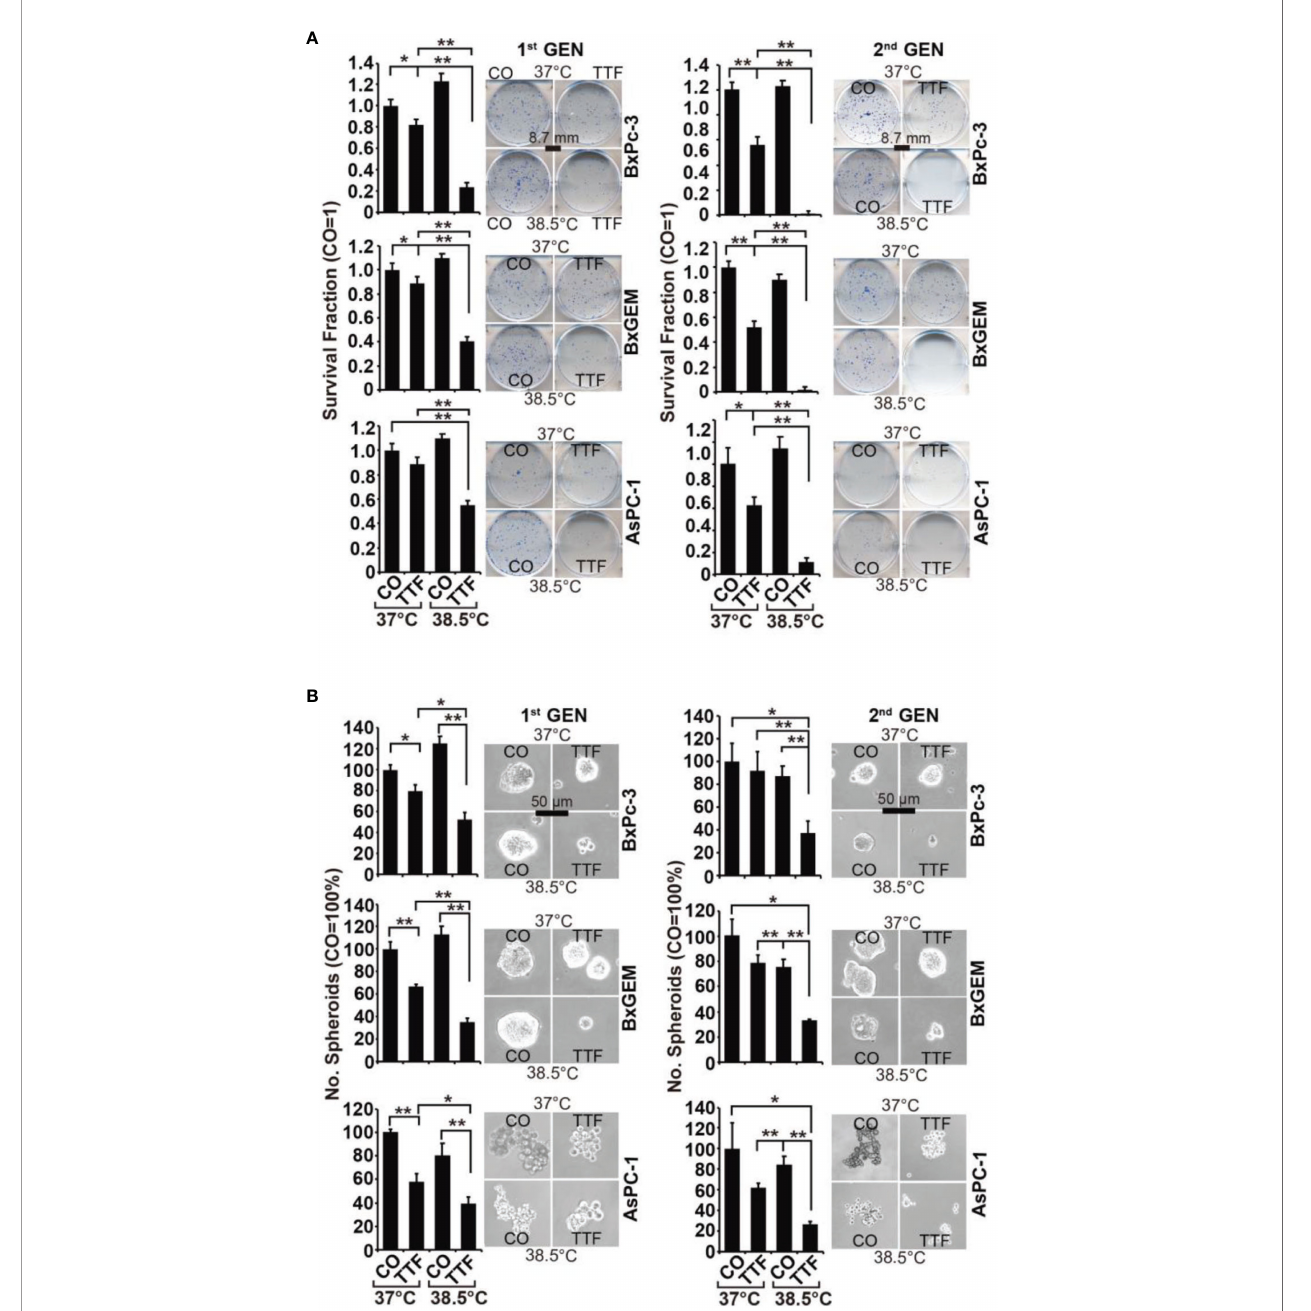
FIGURE 2 | TTField-mediated inhibition of cancer stem cell features is enhanced by hyperthermia. (A) The cells were treated as described in Figures 1A, B , (B) After 3 days, the cells were detached from the cell culture plates by trypsinization and reseeded at clonal density (AsPC-1: 1,500 cells/well; BxPC-3 and Bx-GEM: 1,000 cells/well) in 6-well plates. The cells were cultured under regular conditions at 37°C without a medium change for 2 weeks, resulting in fi rst-generation colonies (1 st GEN). The number of colonies was evaluated by fi xing and Coomassie staining, followed by counting colonies with at least 50 cells using a dissecting microscope. The survival fraction and representative images are shown on the left. For the formation of second-generation (2 nd GEN) colonies, surviving cells from each group of fi rst- generation colonies were collected, reseeded and analyzed as described above. (B) After treatment, as described in Figure 1A , the cells were seeded at a clonal density of 500 cells/well in ultralow-attachment 24-well plates in cell growth factor-supplemented serum-free culture medium to induce spheroid formation. Six days later, the fi rst generation of spheroids developed, and the percentage of viable spheroids was evaluated by microscopy at 100× magni fi cation and counting. Representative photographs and the means are shown on the left. For the formation of second-generation spheroids (2 nd GEN), surviving cells were collected from each group of fi rst-generation spheroids and reseeded and analyzed as described above. The data are presented as the means ± SDs. *P < 0.05, **P <